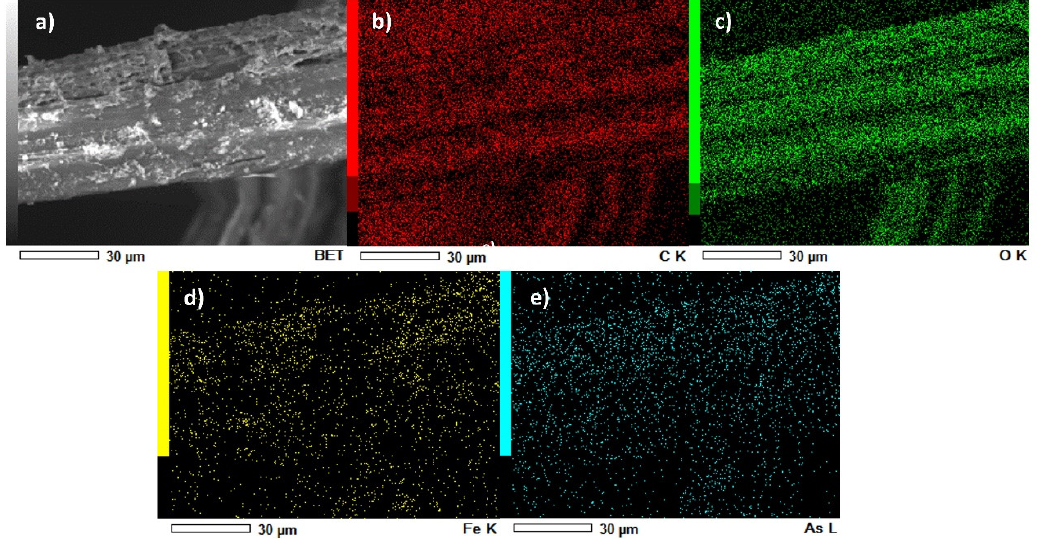
Figure 4. SEM micrographs of ( a ) nZVI nanoparticles by STEM, ( b ) nZVI supported on GO (nZVI/GO), ( c ) natural jute fiber, ( d ) jute fiber activated with nZVI/GO, the white areas indicate the presence of the nZVI/GO hybrid.